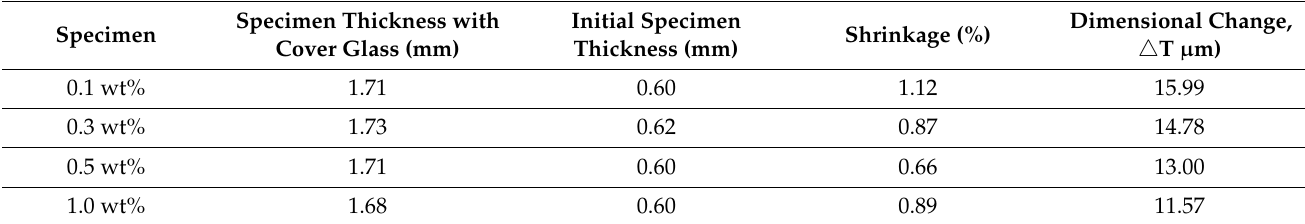
Table 4. Volume change rate of colored epoxy resin through TMA.